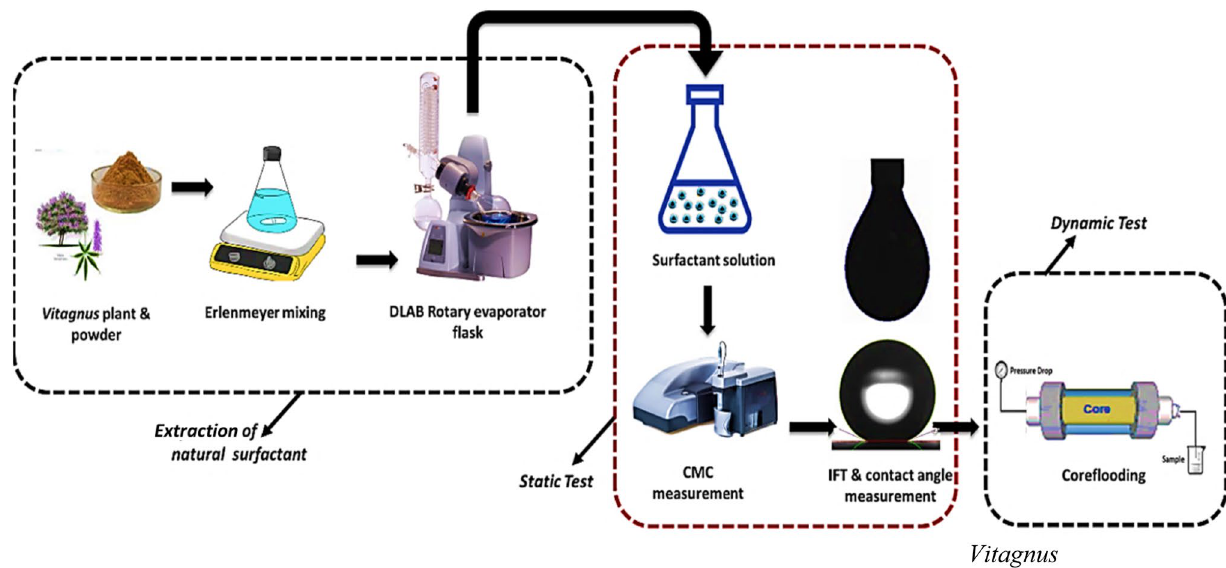
Fig. 2 Schematic representation of the experimental procedures used in the preparation of the Vitagnus plant extract and its application in EOR